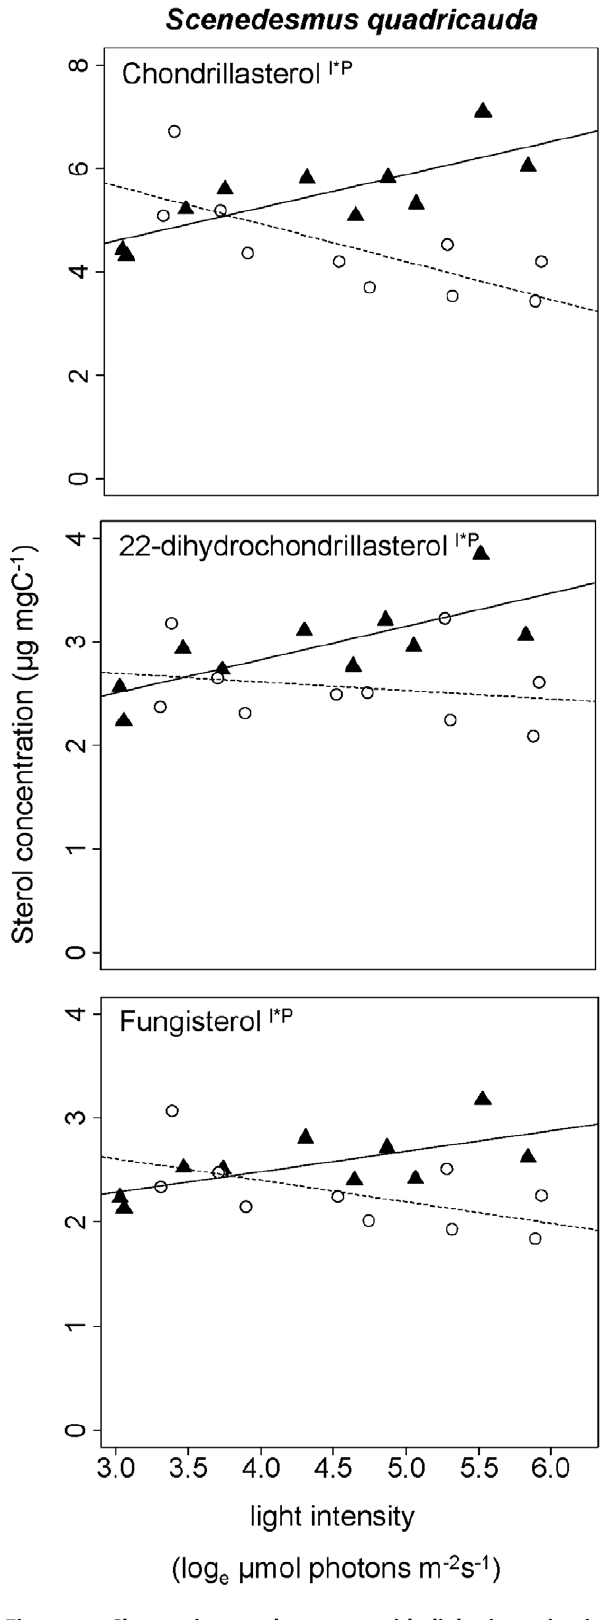
Figure 1. Change in sterol content with light intensity in Scenedesmusquadricauda . ( m , straight line) High-P treatments. ( # , dashed line) Low-P treatments. Each data point represents a single